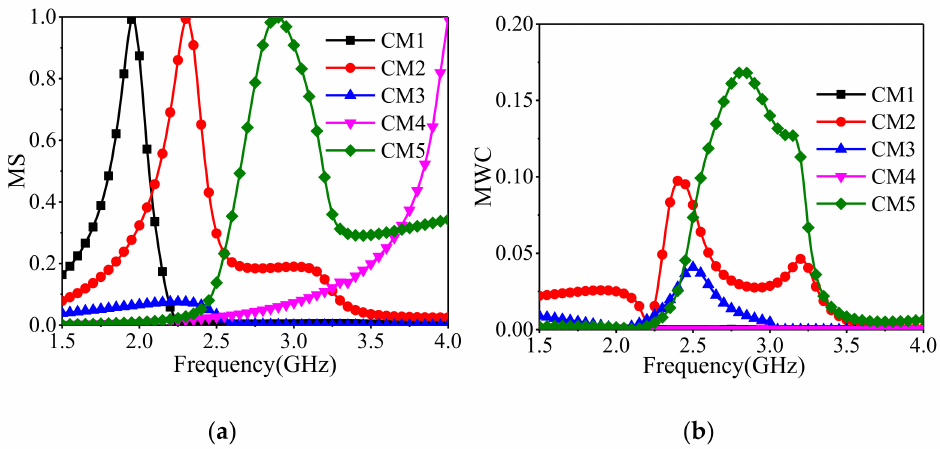
Figure 7. Modal significances and modal weighting coefficients for the first five modes of the proposed antenna. ( a ) modal significances, ( b ) modal weighting